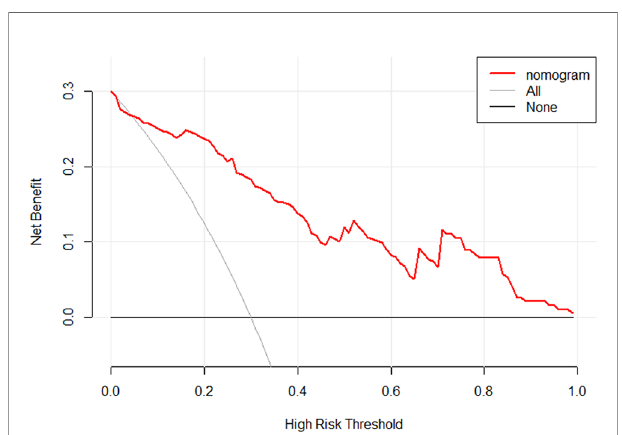
FIGURE 7 | The DCA for the developed radiomics nomogram. The y-axis represents the net bene fi t. The x-axis represents the threshold probability. The black line at the bottom named “ None ” represented the hypothesis that no patients had long OS, which meant the net bene fi t would be zero if all patients did not have the long OS. The gray line named “ All ” represents the hypothesis that all patients had long OS. The red line represents the net bene fi t of the radiomics nomogram at different threshold probabilities. The result indicated the radiomics nomogram to stratify the OS of GBM patients could yield clinical net bene fi